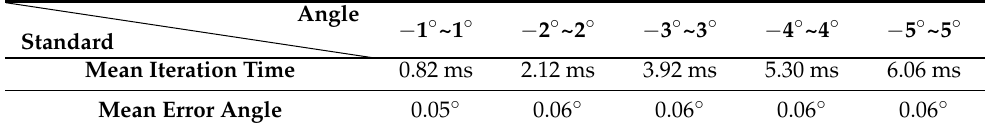
Table 3. Simulation result of model performance.